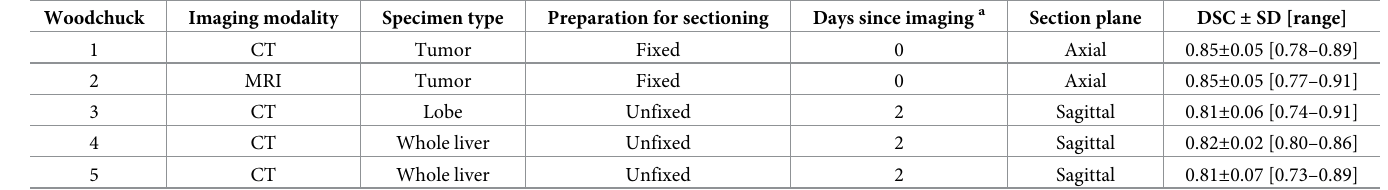
Table 1. Study parameters and degree of spatial overlap of histopathology and in vivo imaging. Woodchuck Imaging